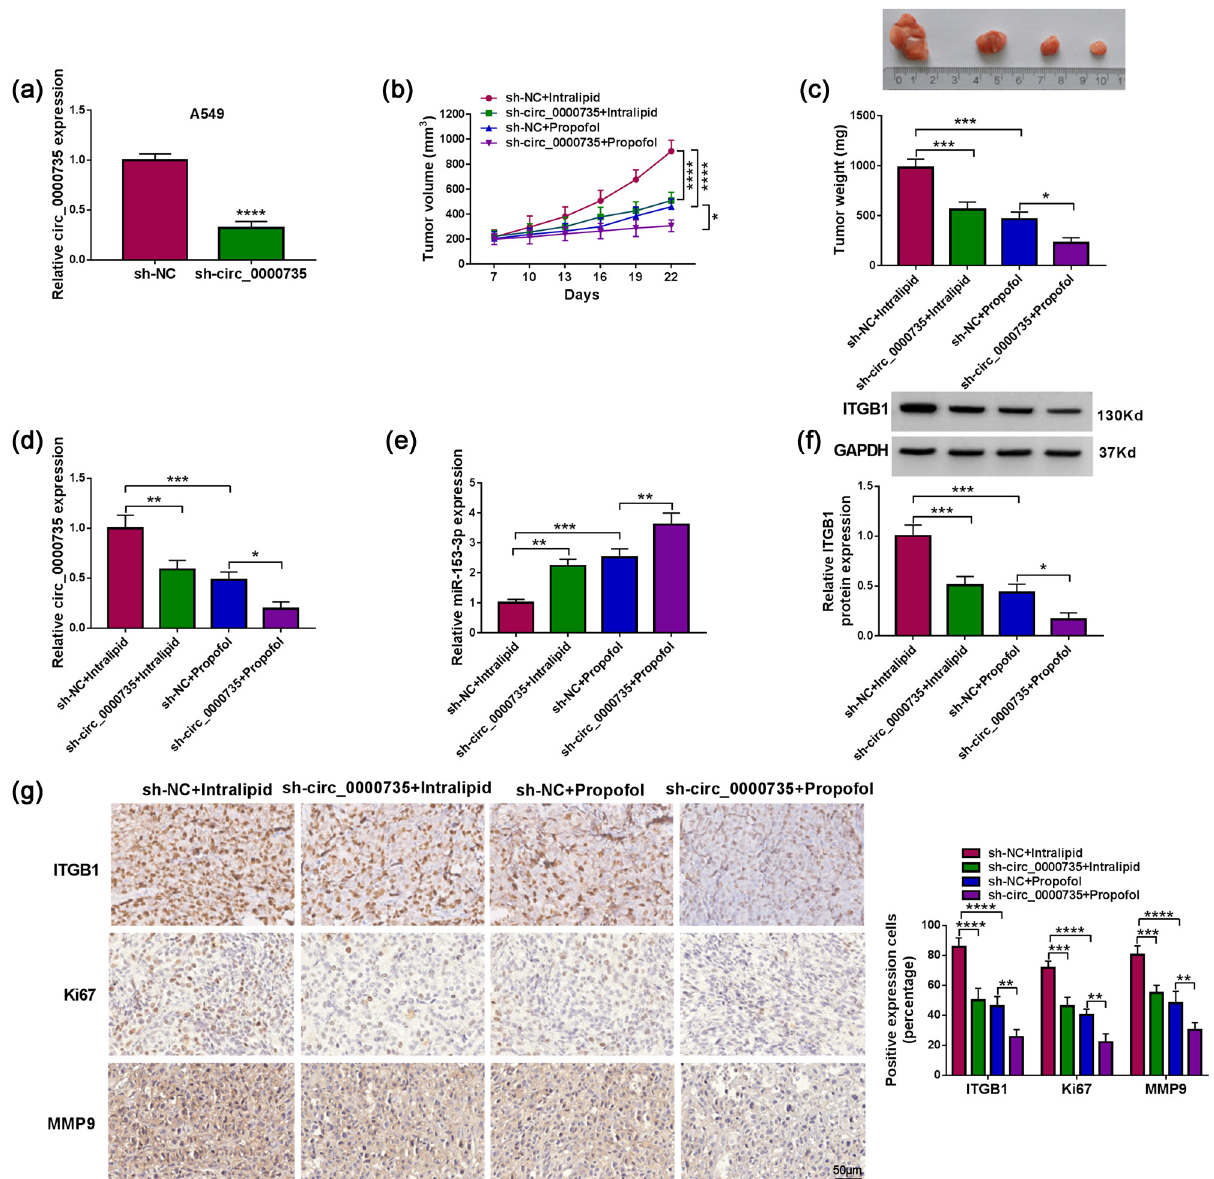
Figure 8: Propofol decreased xenograft tumor growth via downregulating circ_0000735 in vivo . ( a ) RT - qPCR analysis of circ_0000735 in A549 cells carrying sh - circ_0000735 or sh - NC ( n = 3 ) . ( b and c ) Growth curves, representative images, and weights of xenograft tumors in sh - NC + intralipid, sh - circ_0000735 + intralipid, sh - NC + propofol, and sh - circ_0000735 + propofol groups ( n = 8 ) . ( d and e ) Analysis of circ_0017639, miR - 153 - 3p, and ITGB1 in xenograft tumors derived from sh - NC + intralipid, sh - circ_0000735 + intralipid, sh - NC + propofol, and sh - circ_0000735 + propofol groups by RT - qPCR or western blotting ( n = 3 ) . ( g ) Analysis of ITGB1, Ki67, or MMP9 in xenograft tumors derived from sh - NC + intralipid, sh - circ_0000735 + intralipid, sh - NC + propofol, and sh - circ_0000735 + propofol groups using IHC ( n = 3 ) . * P < 0.05, ** P < 0.01, *** P < 0.001, and **** P <